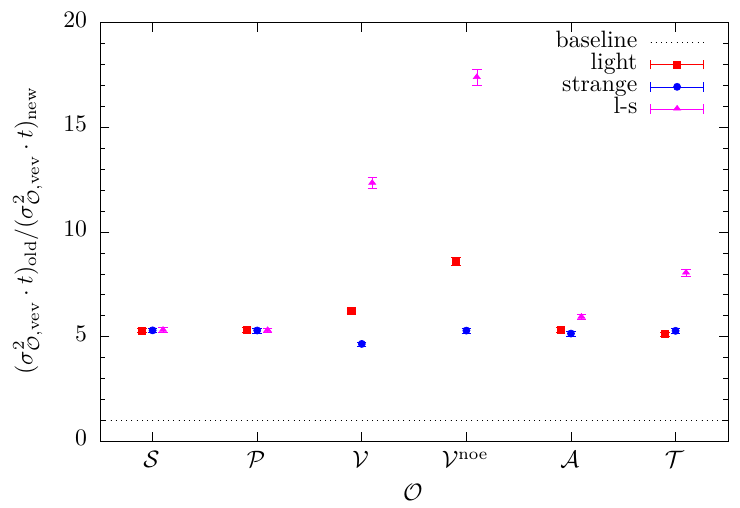
Figure 17 . Speedup of the “new” (OET + gHPE + HP) method over the “old” (plain hierarchical probing) setup for scalar ( S ), pseudoscalar ( P ), vector ( V ), conserved vector ( V noe ), axialvector ( A ) and tensor ( T ) quark bilinear operators. Results are shown for individual light and strange flavors as well as for the l − s combination obtained directly from the OET. For operators that had reached gauge noise already for the old setup a speedup of roughly a factor five is obtained, while for the l − s combination of the vector currents speedups of more than an order of magnitude are